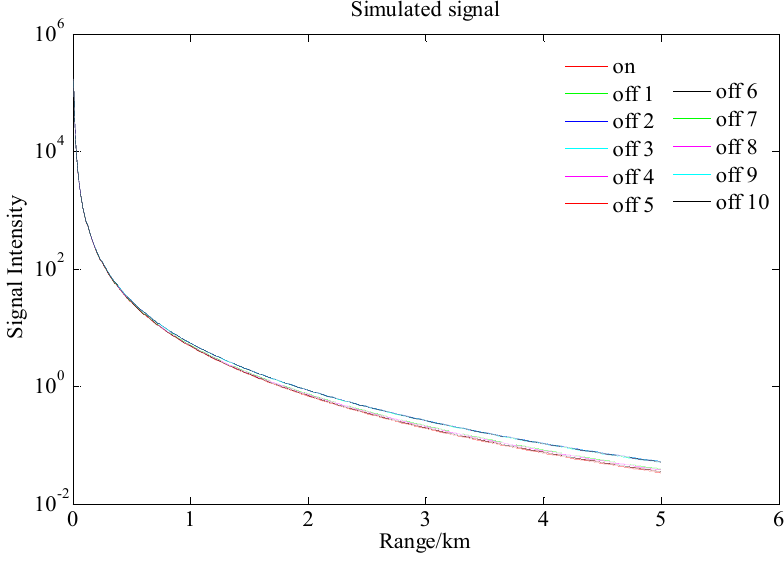
Figure 10. Simulated echo signal of MW-DIAL.